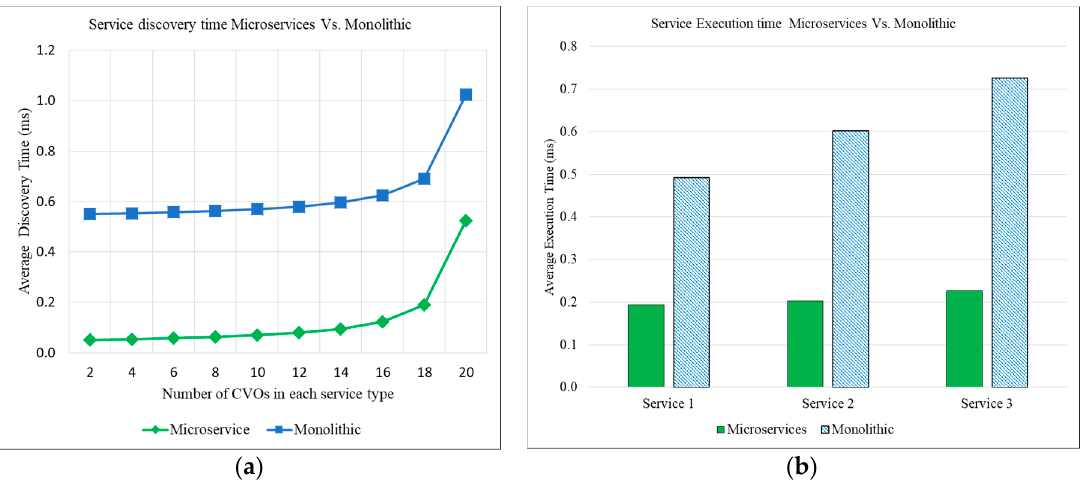
Figure 7. ( a ) Average discovery time for the service with the same number of CVOs with microservices vs. monolithic; and ( b ) average execution time for the service with microservices and monolithic approach.